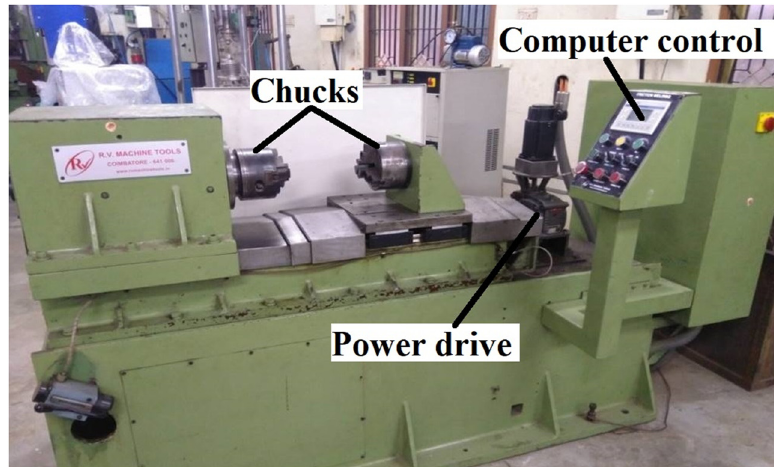
Figure 2: Photograph of the RFW machine used to develop rod - to - plate joints.